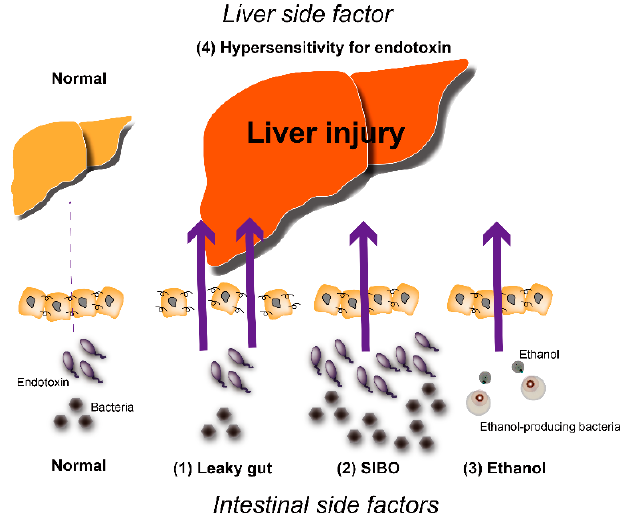
Figure 1. Mechanisms of NAFLD progression promoted by intestinal and hepatic side factors. SIBO; small intestinal bacterial overgrowth.